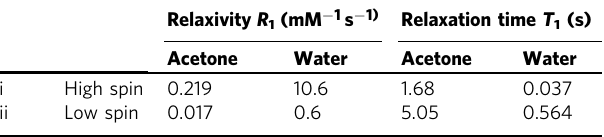
Table 2 Relaxivities and relaxation times of the